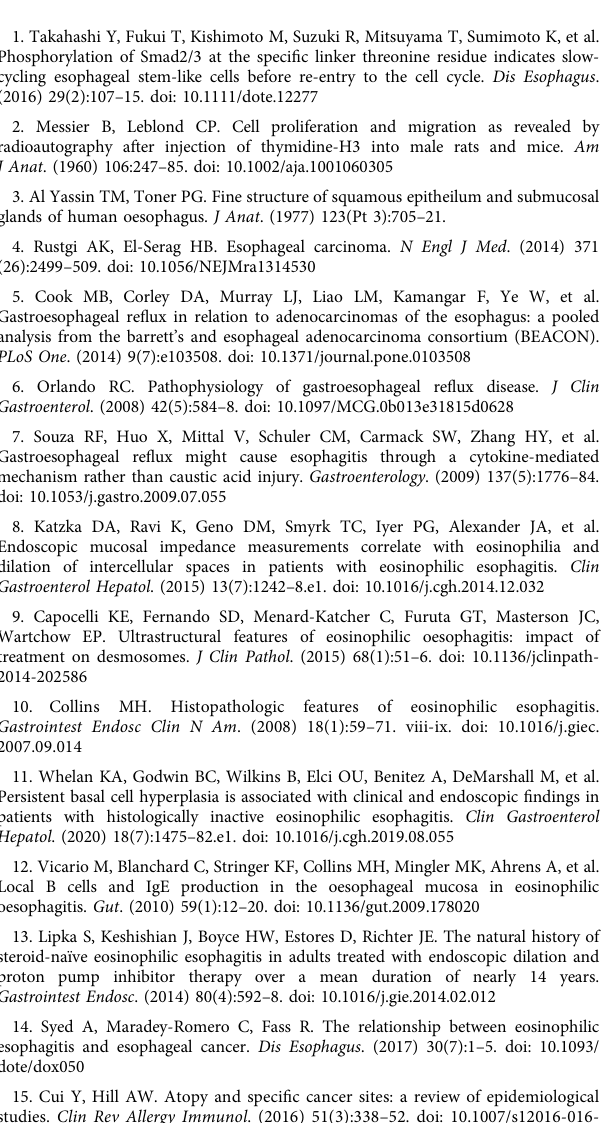
Supplementary Figure S1 Changes in esophageal epithelial cell populations between untreated, eosinophilic esophagitis (EoE)-treated, and esophageal squamous cell carcinoma (ESCC)-treated esophagi. Uniform Manifold Approximation and Projection plot (UMAP) showing cell populations identi fi ed across entire single cell RNA-Sequencing dataset separated by experimental